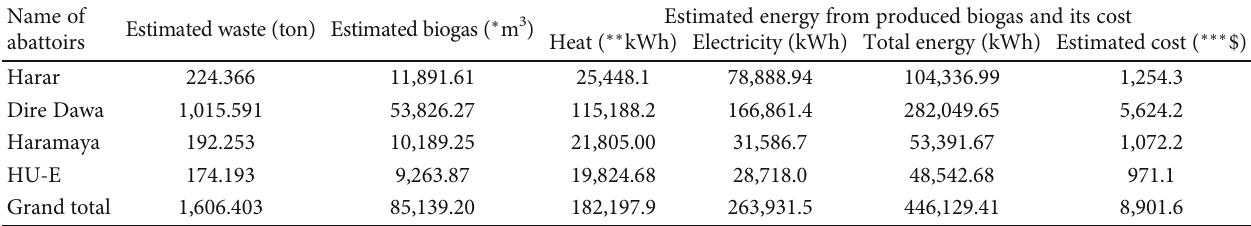
Estimated energy from produced biogas and its cost